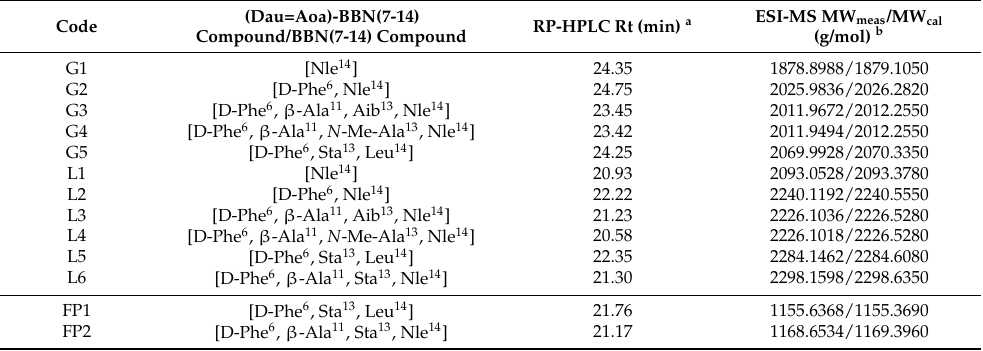
Table 1. Chemical characterisation of LRRY ( L1 – L6 ) and GFLG ( G1 – G5 ) linker containing Dau-BBN (7-14) conjugates and free peptide analogues ( FP1 and FP2 ).